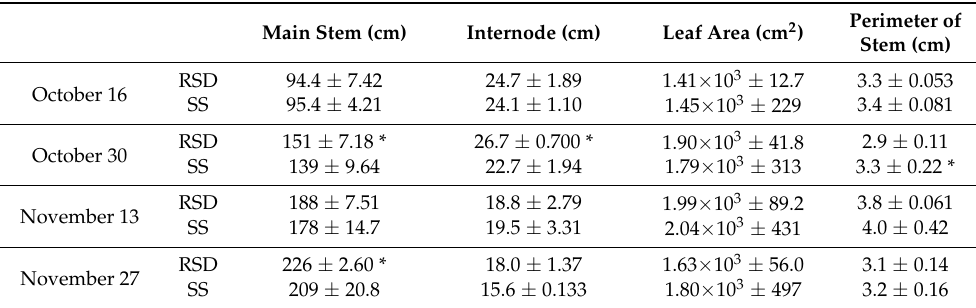
Table 1. Evaluation of the cultivated tomato plant growth after reductive soil disinfestation (RSD) and soil solarization (SS). Values are the average and standard deviation. Asterisks indicate statistically significant differences ( p < 0.05) by Welch’s t